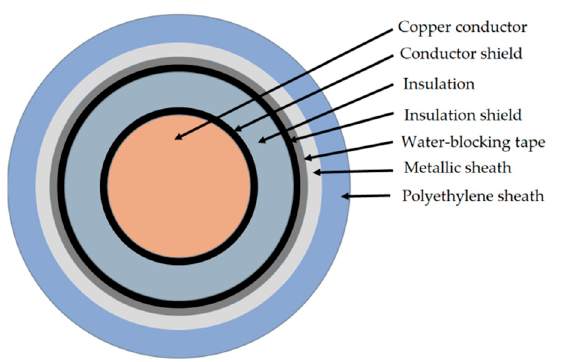
Figure 1. Geometry of the 320 kV high voltage–direct current (HVDC) cable. Table 1. Size and the material parameter of the 320 kV HVDC